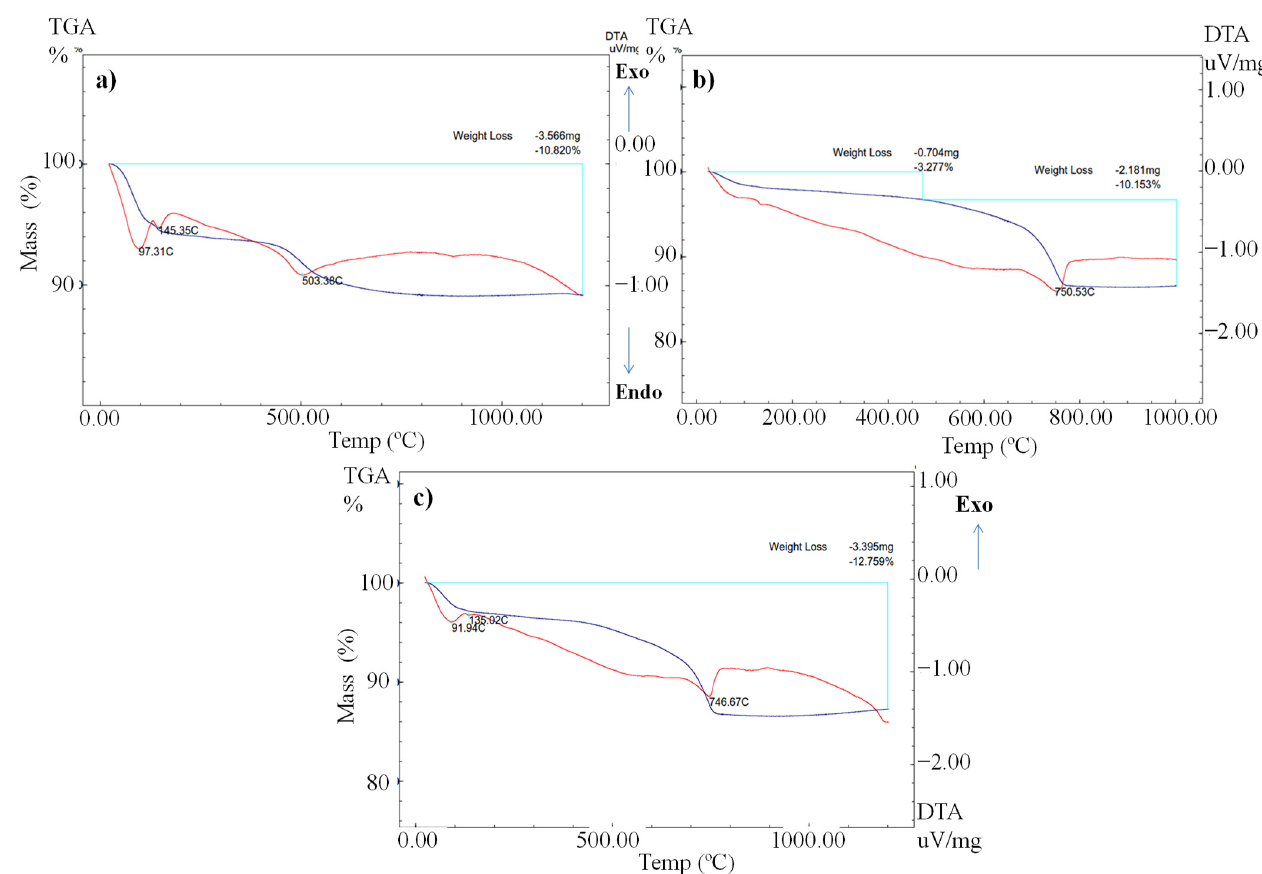
Figure 5. Differential thermal and thermogravimetric analysis of ( a ) DM, ( b ) HM, and ( c ) SM. Red and blue lines represent DTA and TGA diagrams, respectively. Table 5. Technological features of clays and unfired brick specimens.